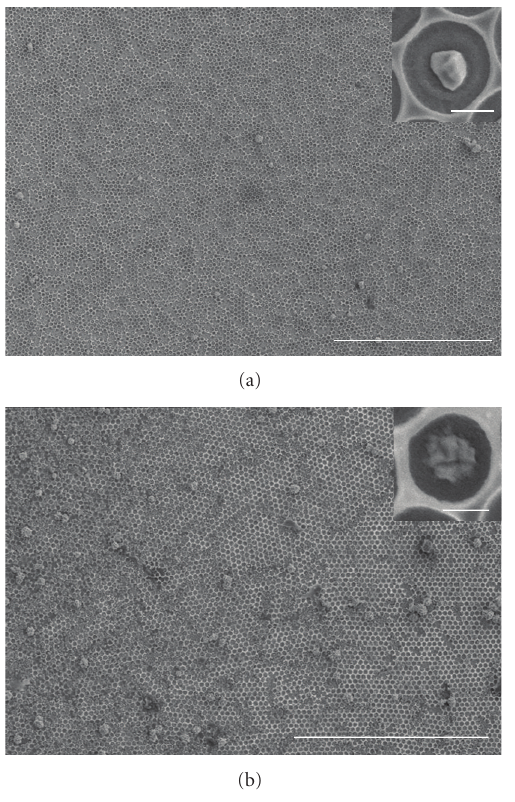
Figure 6: SEM images of (a) narrow bottom and (b) wide bottom films. Insets display representative gold deposits within silica nanowells. (Scale bars: 20 µ m, inset: 250 nm).